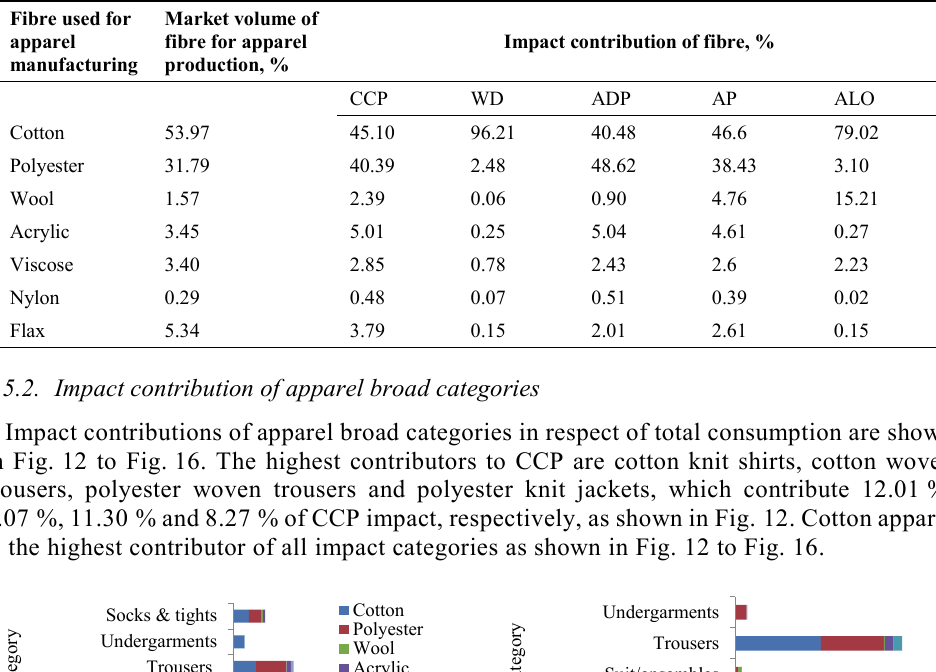
wearSweater & DressSports/swim